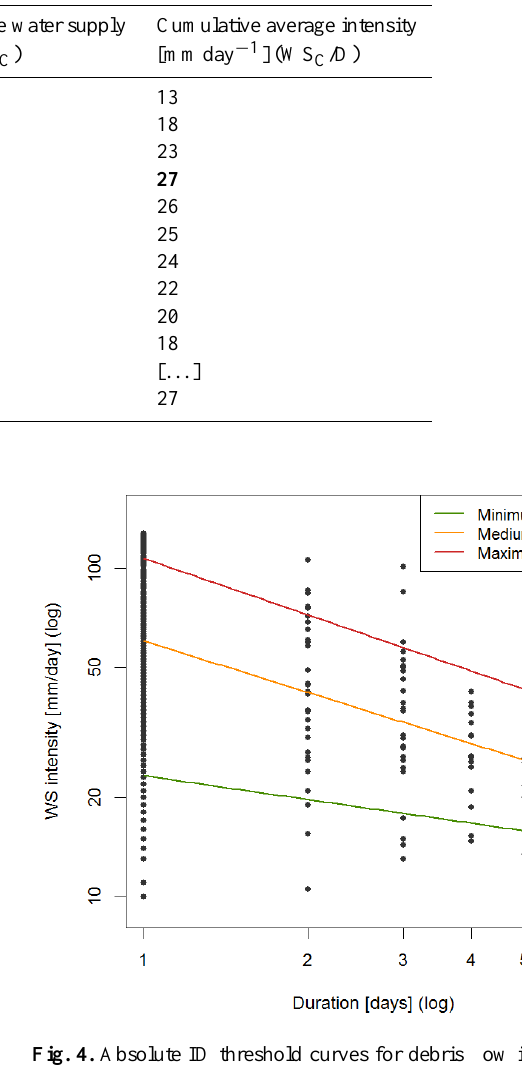
Fig. 4. Absolute ID threshold curves for debris flow initiation ob- tained from the water supply (WS) intensity 3-day moving aver- age of the 5th and 15th percentiles (minimum threshold), the 45th and 55th percentiles (medium threshold) and the 85th and 95th per- centiles (maximum threshold) ( n = 502). cur. The three threshold levels are marked by the color code green, orange and red, which is common for indication of different warning levels in natural hazard research. Different warning levels in an early warning system are able to define different levels of